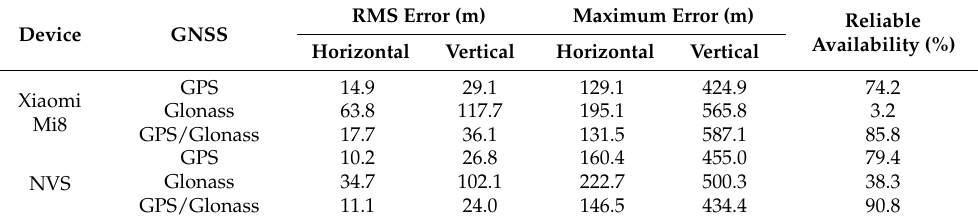
Table 6. Comparison between Xiaomi Mi8 and NVS, with RAIM application (only reliable epochs). Device GNSS